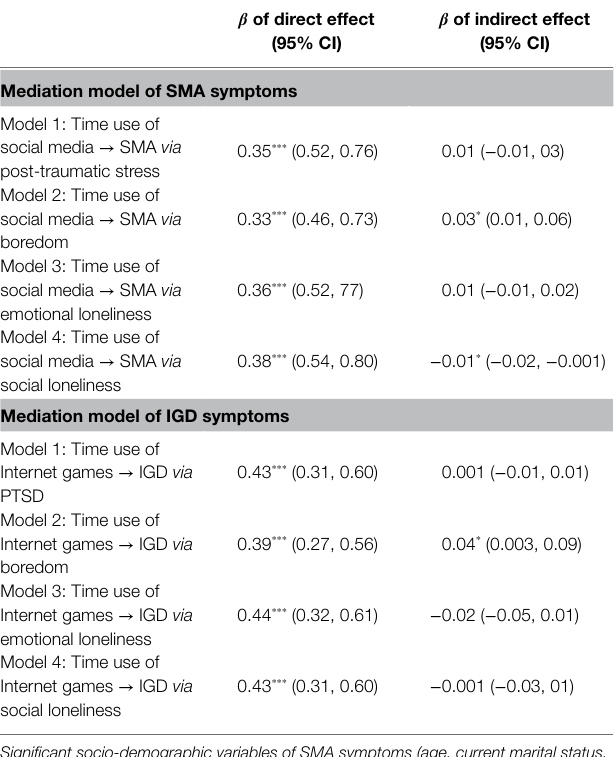
β of direct effect β of indirect effect (95% CI) (95% CI)